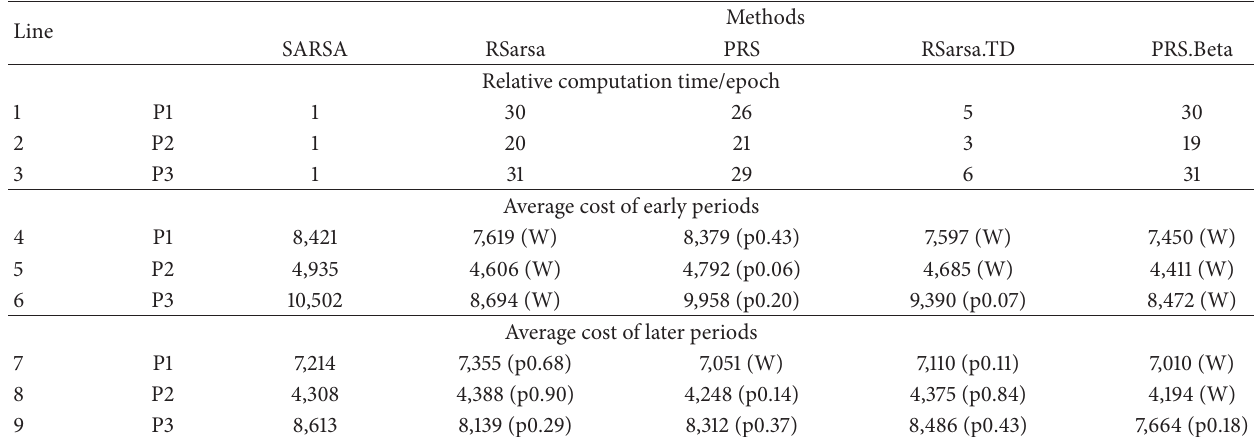
Table 1: Experimental